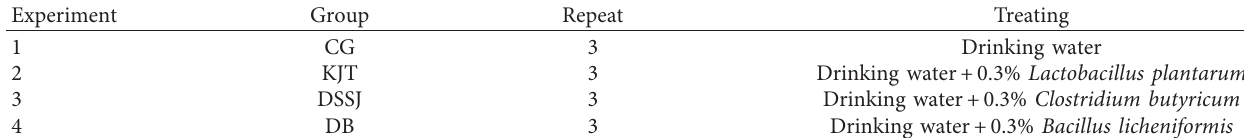
Table 1: Test results of growth performance.